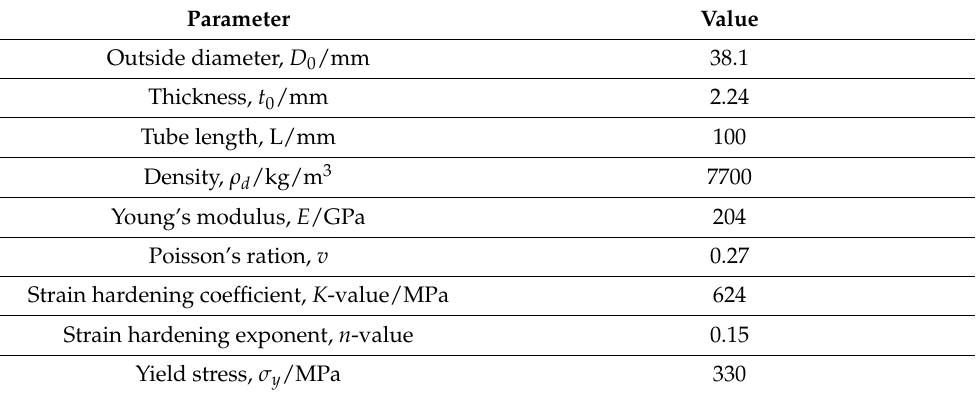
Table 1. Material properties of the